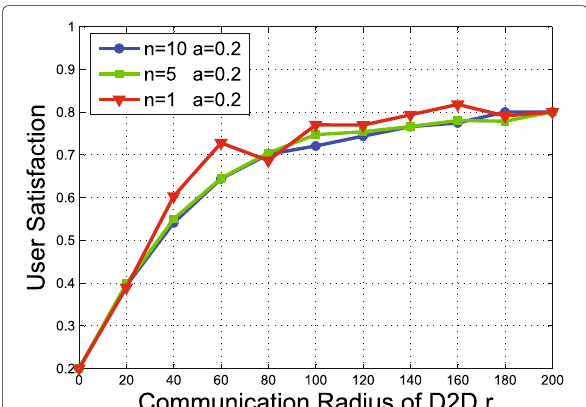
Fig. 12 The relationship between user satisfaction and D2D communication radius with γ c = 1 and a = 0.2. This figure illustrates the effect of system outage probability and user transmission rate on user satisfaction